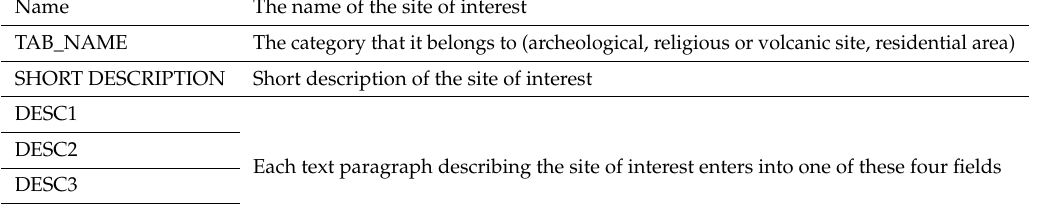
Table 3. Comma Separated Value text file schema.